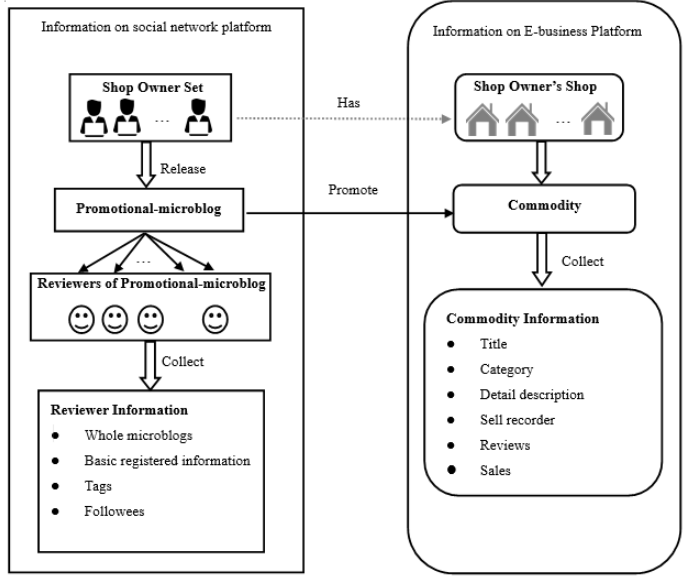
Figure 7. The detailed process of collecting data.